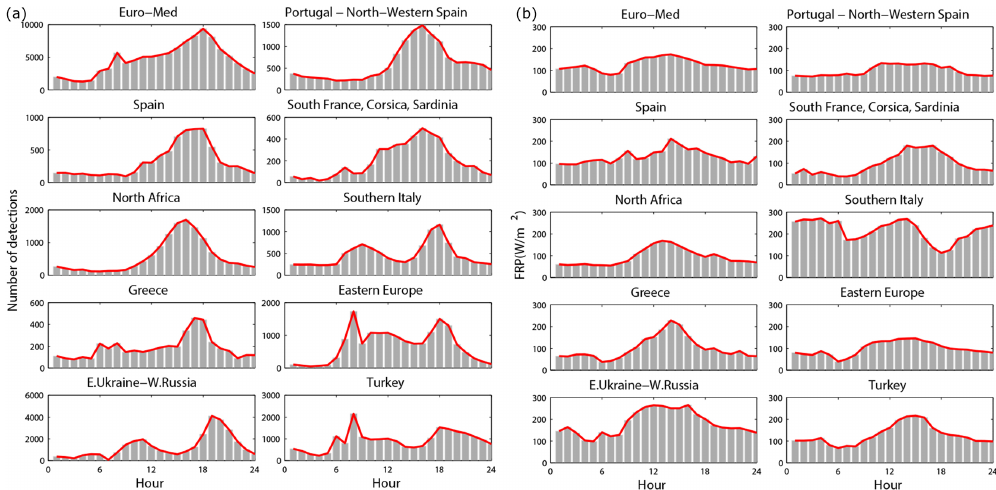
Fig. 6. Hourly variation of the number of fires detected by the MSG/SEVIRI instrument (a) and of the average FRP measurements over several subregions of the domain for the 2008–2010 time period (July–August only). The red line shows the corresponding averaged diurnal